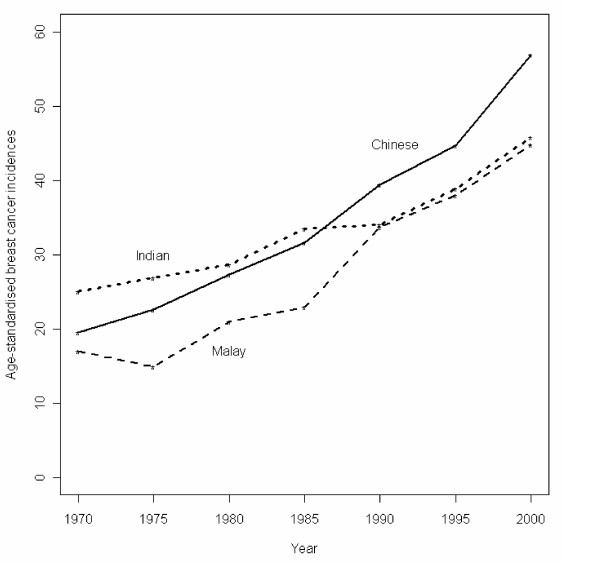
Age-standardized incidence rates of breast cancer stratified by ethnic group from 1968 to 2002 (as indicated by the mid-year of the 5-yearly intervals).